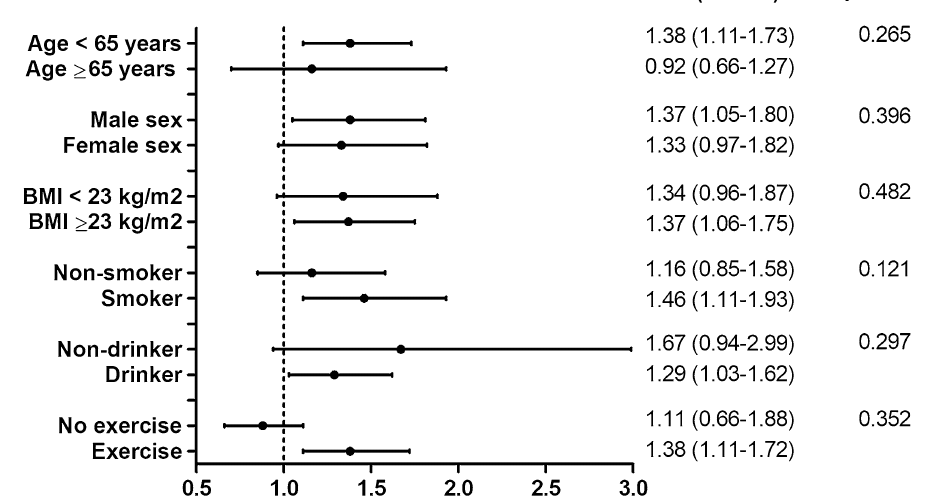
Figure 3. Multivariable adjusted associations between periodontitis and serum TSH levels among participant subgroups. ORs for the 1st tertile group in reference to the 3rd tertile group are presented with 95% CIs. Abbreviations: CI, confidence interval; TSH, thyroid-stimulating